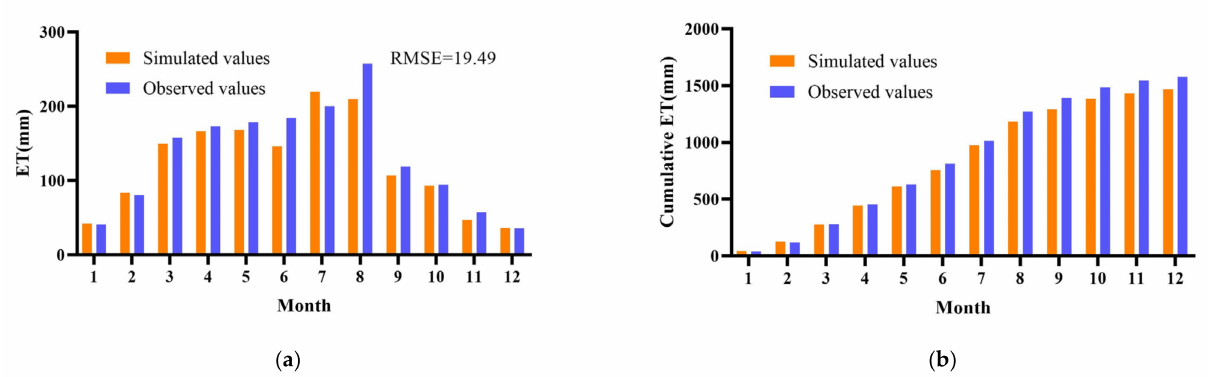
Figure 5. Comparison of simulated and observed values. ( a ) is the monthly simulated and measured ET. ( b ) is the monthly accumulation of simulated and measured